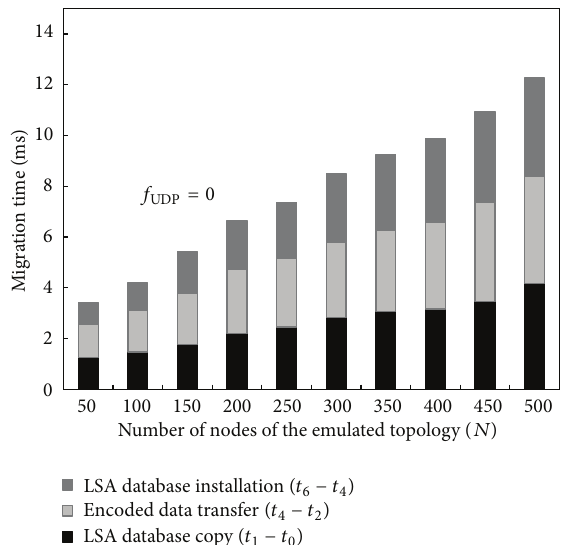
Figure 15: Migration time as a function of the number 𝑁 of nodes is in the emulated network. The UDP traffic rate 𝑓 UDP to 700